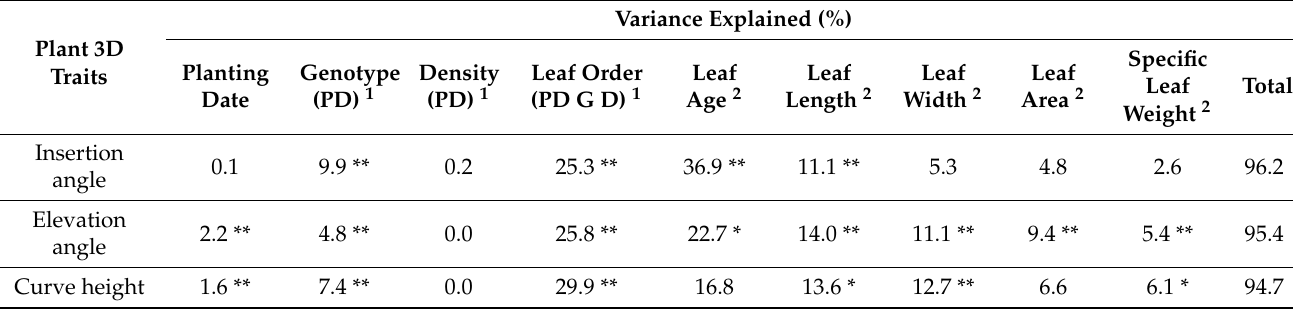
Variance Explained (%)